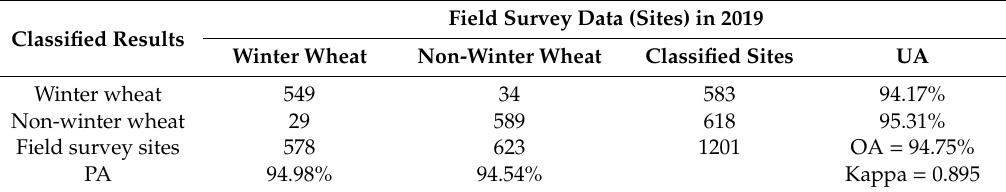
Table 2. Accuracy assessment using field survey data (sites) in 2019.